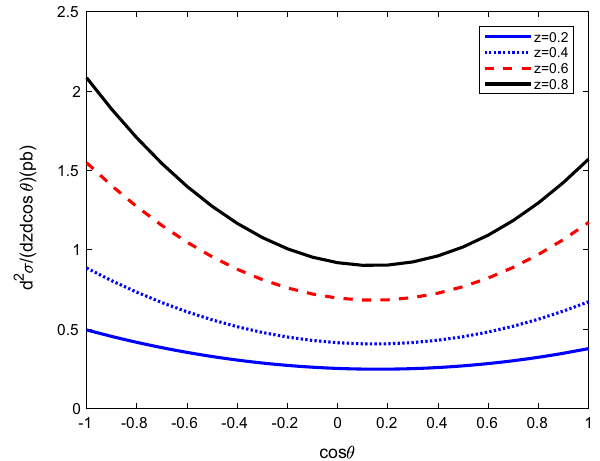
Fig. 1 The differential cross section d 2 σ/( dz d cos θ) for the produc- tion of the B c ( 1 1 S 0 ) meson at the Z pole under the fragmentation- function approach up to NLO+NLL level, where θ is the angle between the momenta of the final B c meson and the initial electron